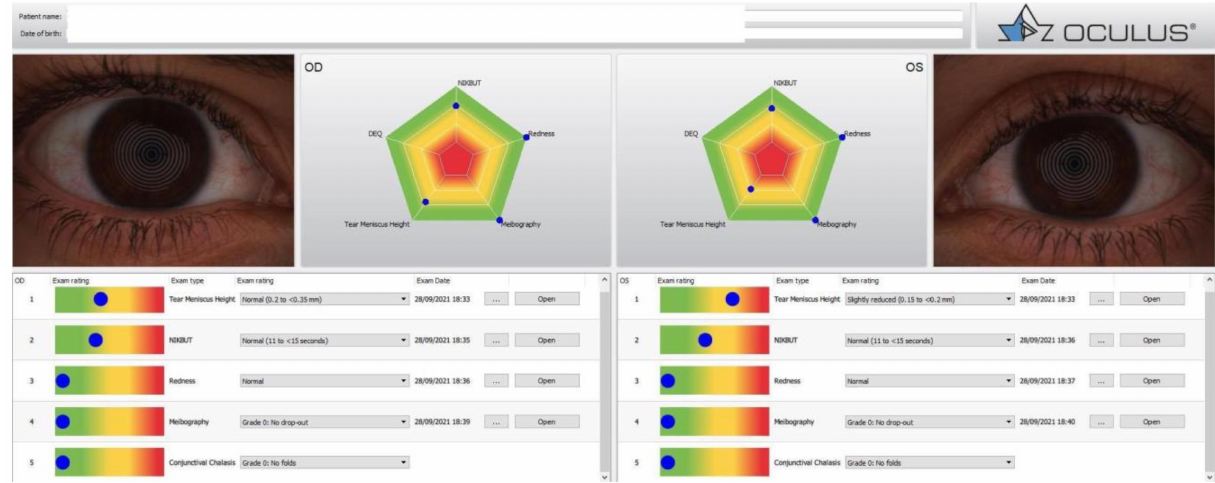
Figure 1. Dry eye report obtained with the use of Keratograph 5M (Oculus Optikgeräte GmbH, Wetzlar, Germany). A combination of five parameters, including tear meniscus height, non-invasive break-up time, redness, meibography, and conjunctival chalasis, is displayed on a radar chart in a pentagonal